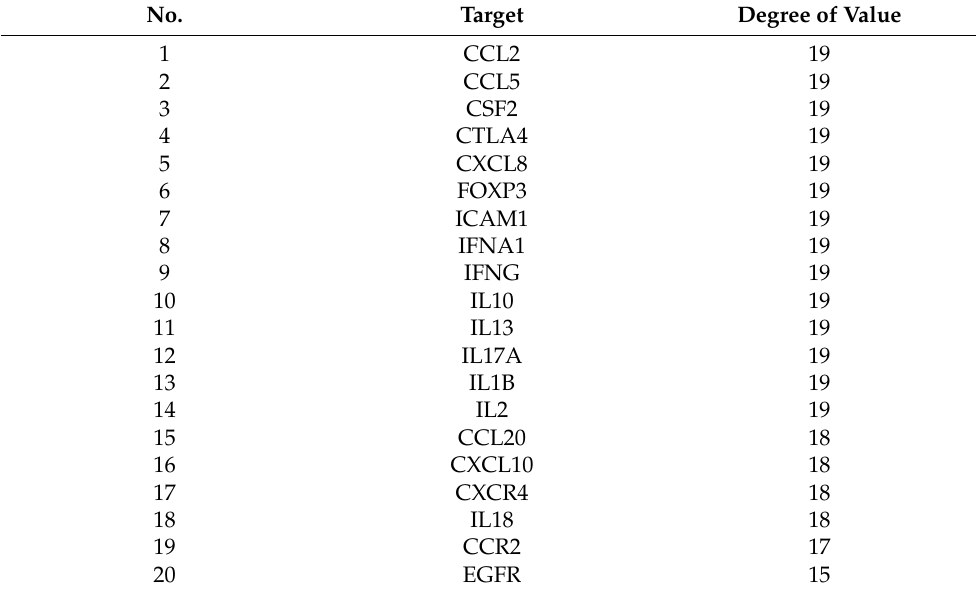
Table 1. Degree of value of the top 30% by betweenness centrality (BC) in PPI.